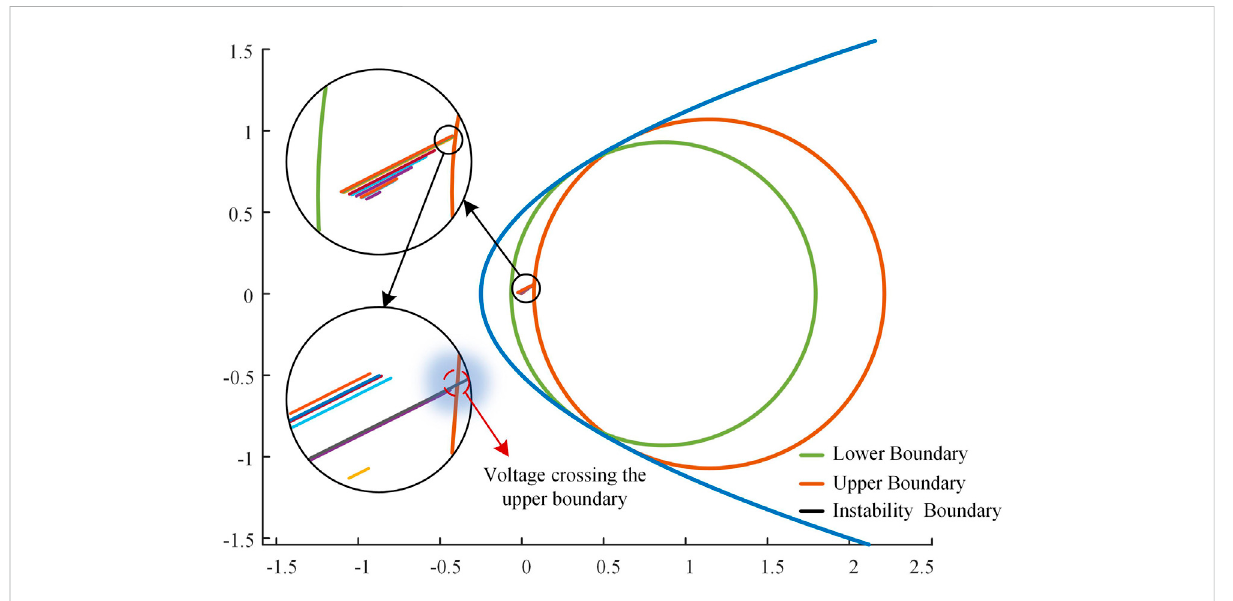
FIGURE 7 Bus sigma index crossing boundary